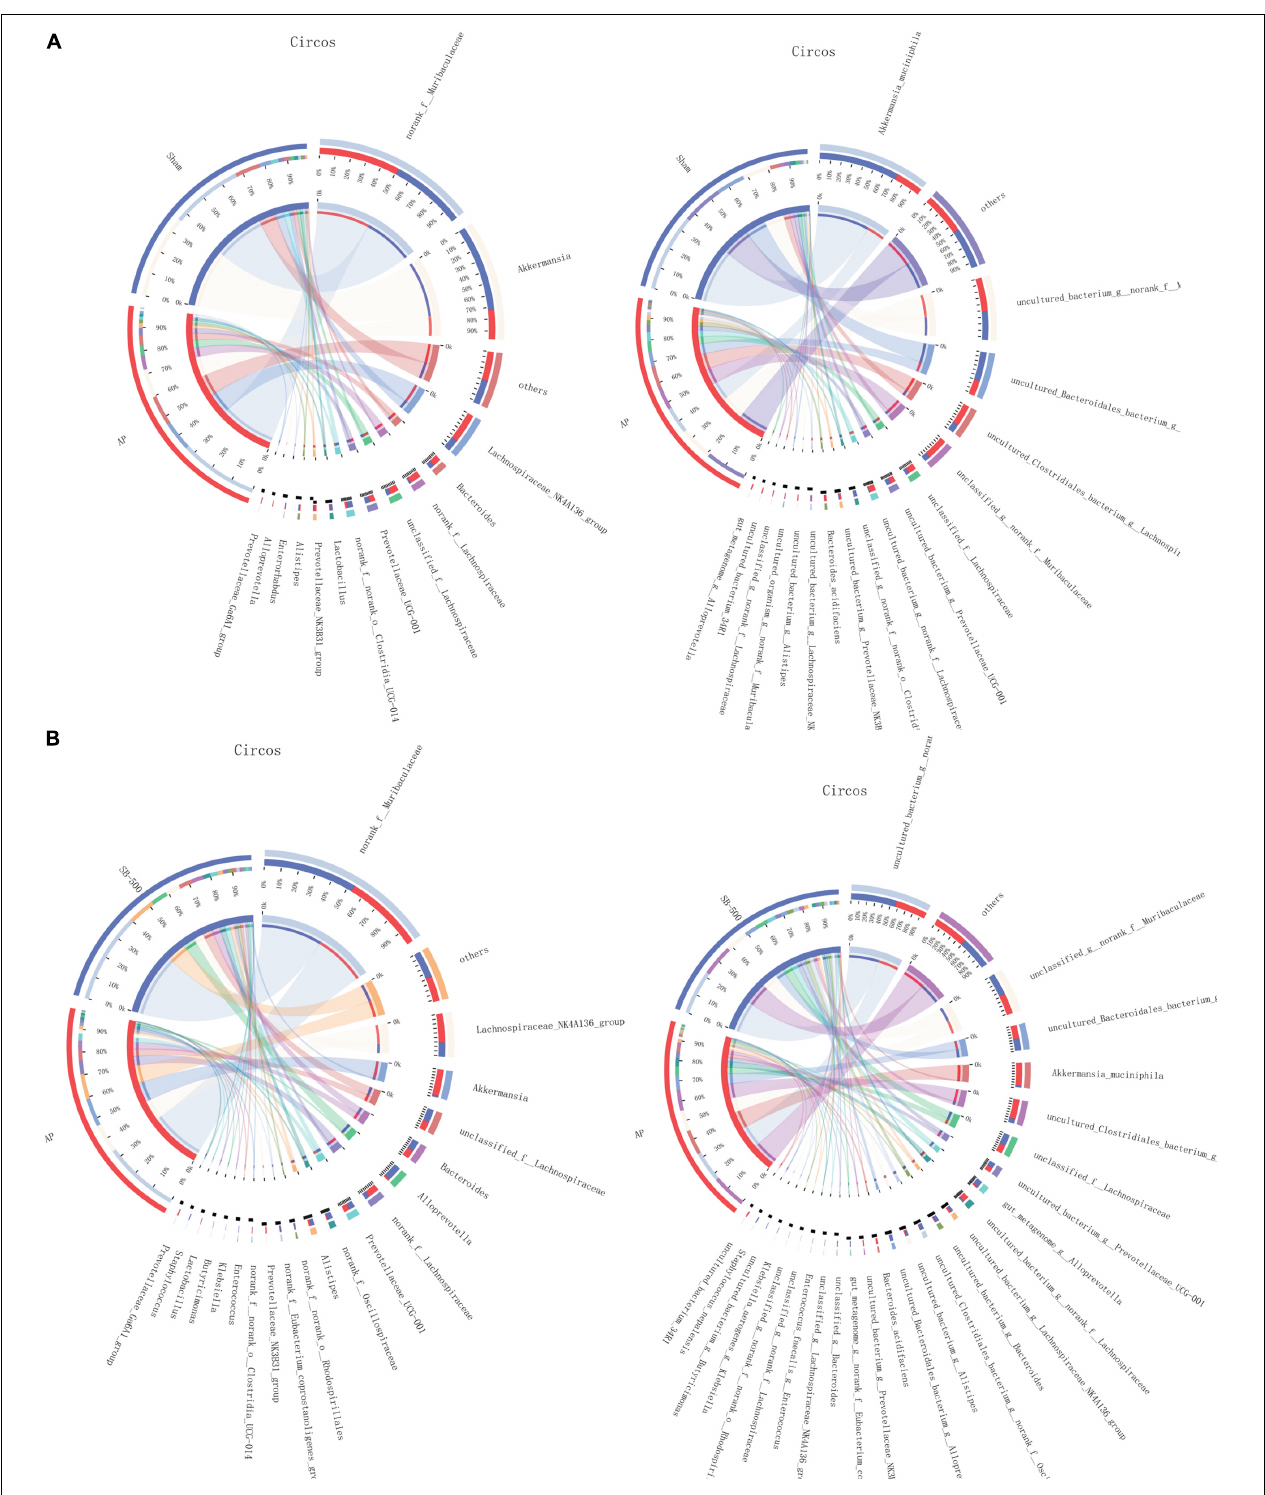
FIGURE 7 | Distribution of the predominant dominant gut microbiota species at the genus and species levels in Circos in the (A) AP vs. Sham and (B) SB-500 vs. AP, at the (a) genus and (b) species level. Sham, Sham operation group; AP, acute pancreatitis group; SB-500, 500 mg/kg butyric acid intervention group.